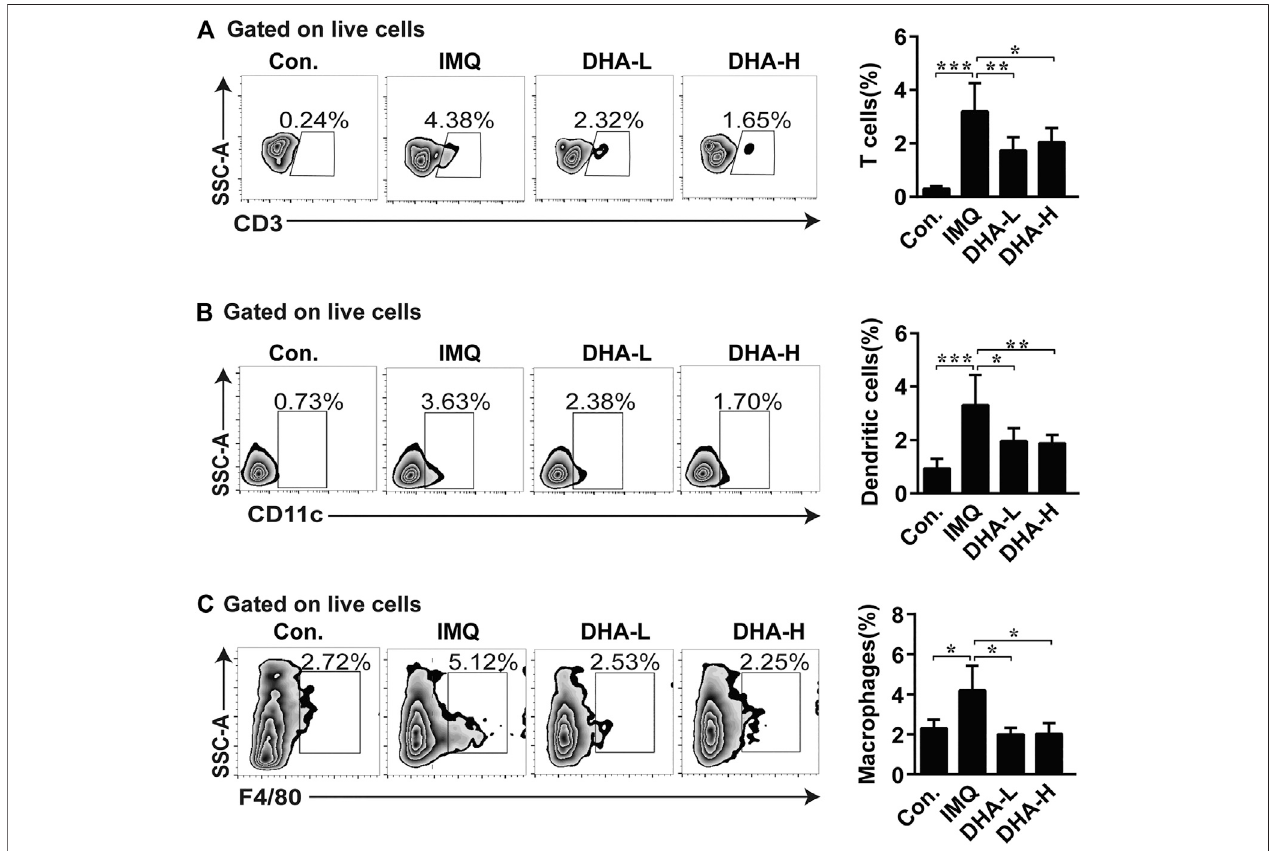
FIGURE 3 | DHA treatment decreased immune cells in fi ltration into skins. (A – C) Percentages of T cells, macrophages, and DCs among total live cells were determined by fl ow cytometry (T cells, * p (cid:2) 0.0328, ** p (cid:2) 0.0074, *** p < 0.001; macrophages cells, * p < 0.05; DCs, * p (cid:2) 0.0141, ** p (cid:2) 0.0097, *** p < 0.001). Statistical analysis was carried out using One-way ANOVA analysis of variance followed by Dunnett ’ s test ( n (cid:2) 4 – 6).